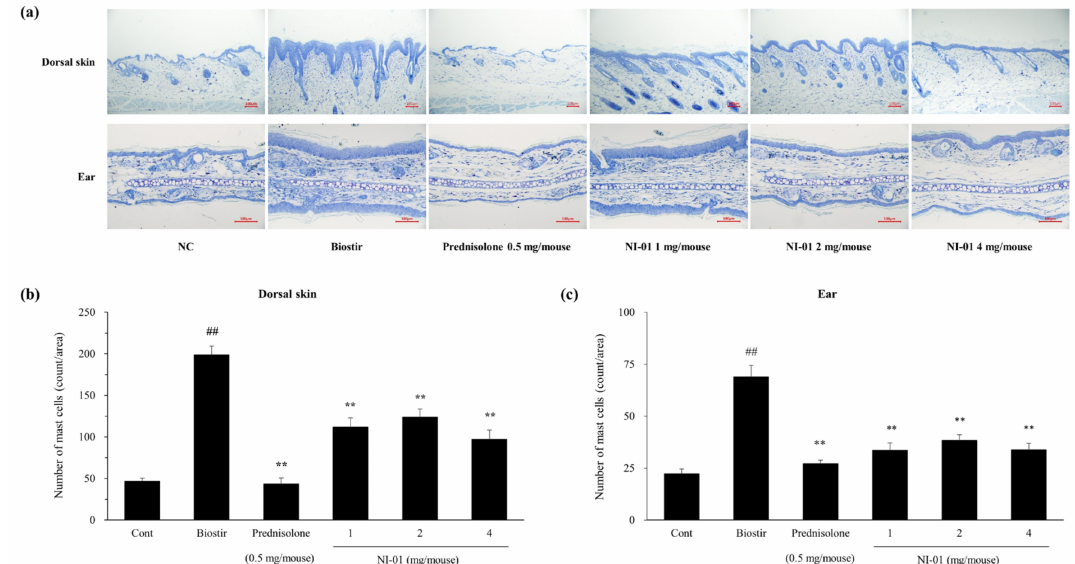
Figure 6. E ff ect of NI-01 on the mast cell infiltration in dorsal skin and ear lesions of house dust mite treated NC / Nga mice. Dorsal skin and ear tissues were fixed with 4% paraformaldehyde, embedded in para ffi n and cut into thin sections. ( a ) Sections were stained with toluidine blue, and mast cells of purple color in dorsal skin ( b ) and ear ( c ) lesions were counted in three randomly selected areas under a microscope ( × 20). Prednisolone was used as a positive control. The data are expressed